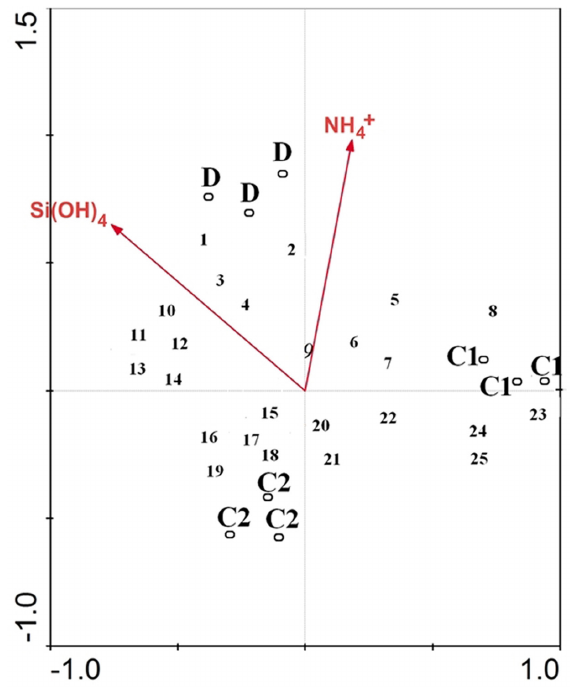
Fig 5. – Diagram of Canonical Correspondence Analysis showing the effects of environmental variables on epiphytic species ordina- tion according to the first and second axes. Number are species: 1, Protoperidinum sp.; 2, Gyrosigma sp.; 3, Cyst of Polykrikos ; 4: Cyst of Karenia selliformis ; 5, Licmophora sp.; 6, Prorocentrum lima; 7, Navicula sp.; 8, Climacosphenia moniligera ; 9 , Pleurosigma sp.; 10, Prorocentrum concavum ; 11, Pinnularia sp.; 12, Biddulphia sp.; 13, Gymnodinium sp.; 14, Prorocentrum rhathymum ; 15: Peridini- um sp.; 16, Amphidinium carterae ; 17, Prorocentrum minimum ; 18, Coolia monotis ; 19 , Merismopedia sp.; 20, Ostreopsis siamensis ; 21, Rhizosolenia sp.; 22, Nitzschia sp.; 23, Amphiprora constricta ; 24, Anabaena sp.; 25, Prorocentrum gracile . Species whose cover- age and frequency less than 10% were